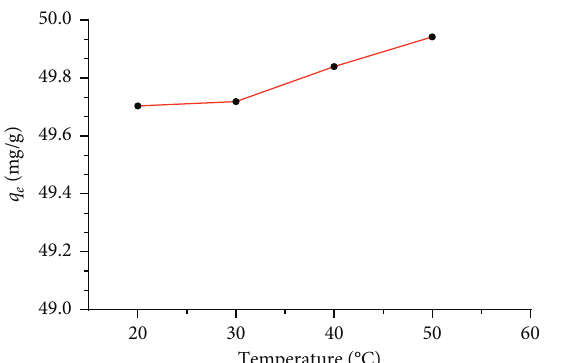
Figure 7: Effect of temperature on adsorption of BG dye onto ASP. Adsorbent amount: 0.2 g, initial BG dye concentration: 50mg/L, V � 200ml, and temperature range: 20–50 ° C.